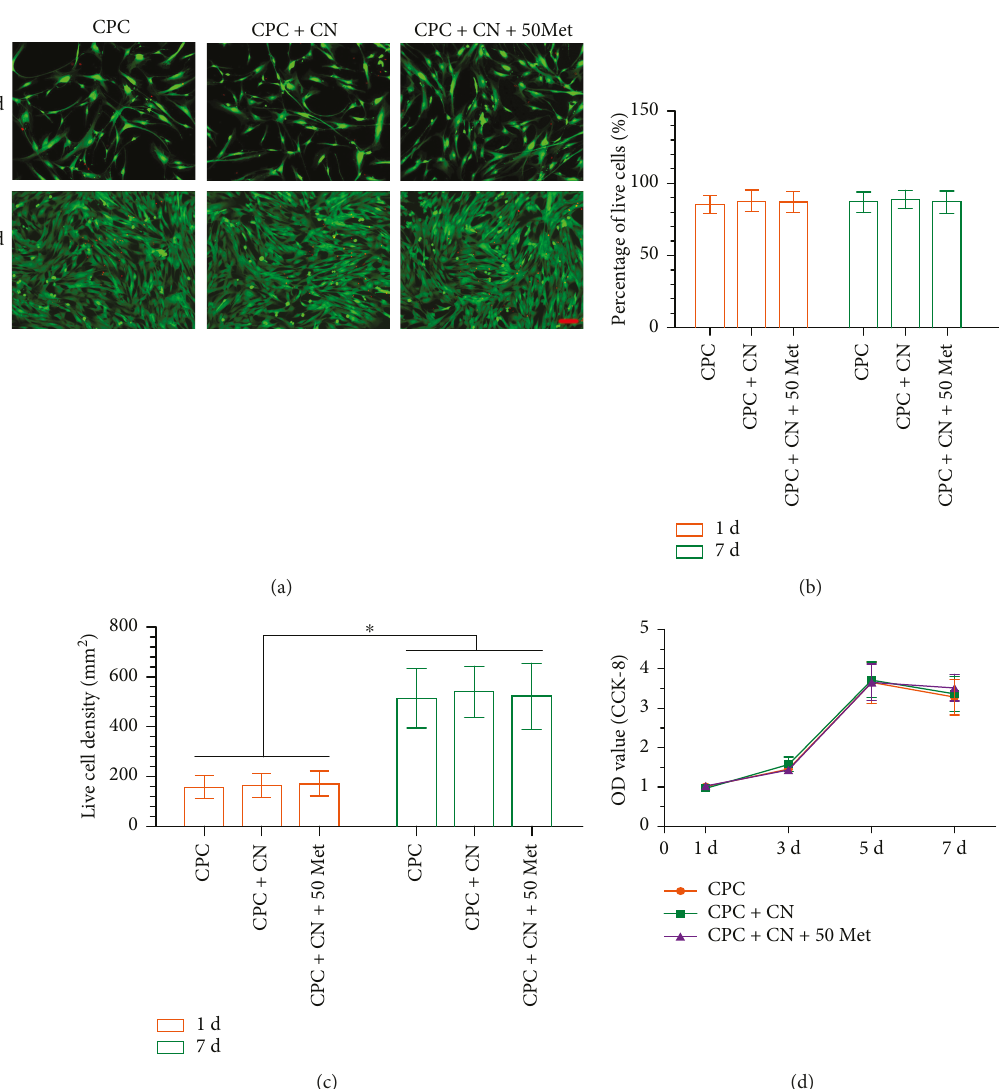
Figure 3: Viability and proliferation of DPCs attached on CPC sca ff old surface. (a) Representative live/dead images of metformin-treated DPCs at days 1 and 7, with live cells stained green and dead cells shown in red. In all three groups, live cells were abundant, and dead cells were few (scale bar =50 μ m). (b) The percentage of live cells of DPCs was around 89%. (c) All groups exhibited an increasing live cell density; ∗ P < 0 05 . (d) CPC +CN + 50Met had no e ff ect on cell proliferation. Data represent mean ± SD of three independent experiments with